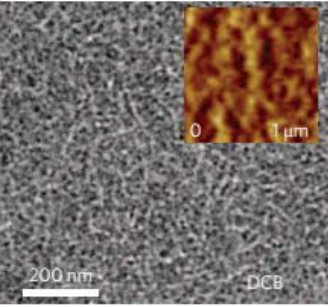
Figure 8. AFM (inset) and transmission electron microscope (TEM) images of